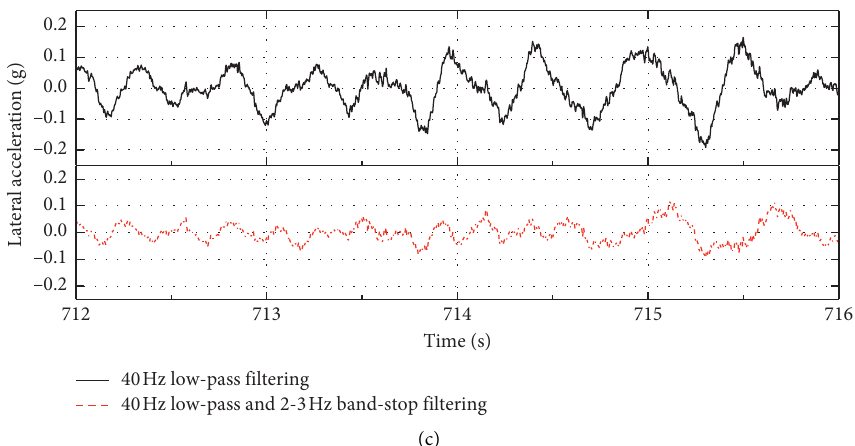
Figure 5: Time-domain analysis of lateral vibration acceleration and stability index of carbody. (a) 40Hz low-pass filtering (all). (b) 40Hz low-pass and 2-3 Hz band-stop filtering (all). (c) Time-domain amplification of carbody lateral vibration